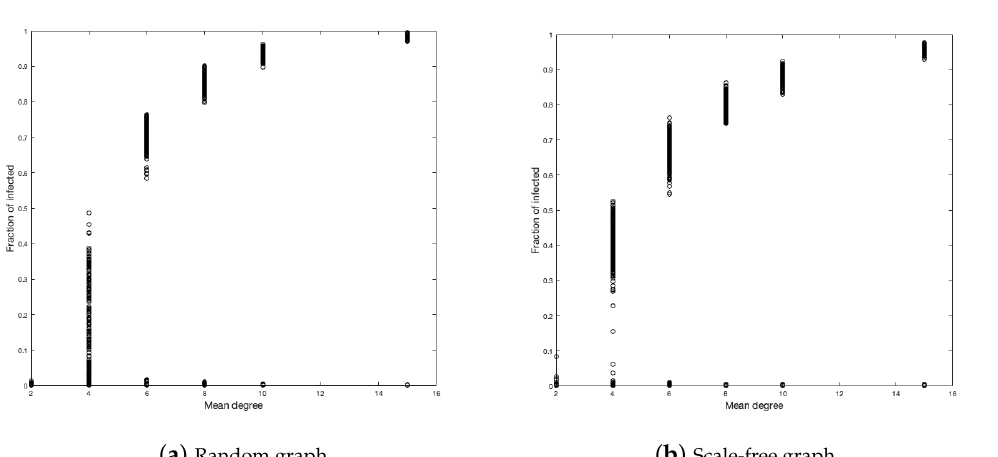
Figure 8. Infected fraction in random and scale-free graph.